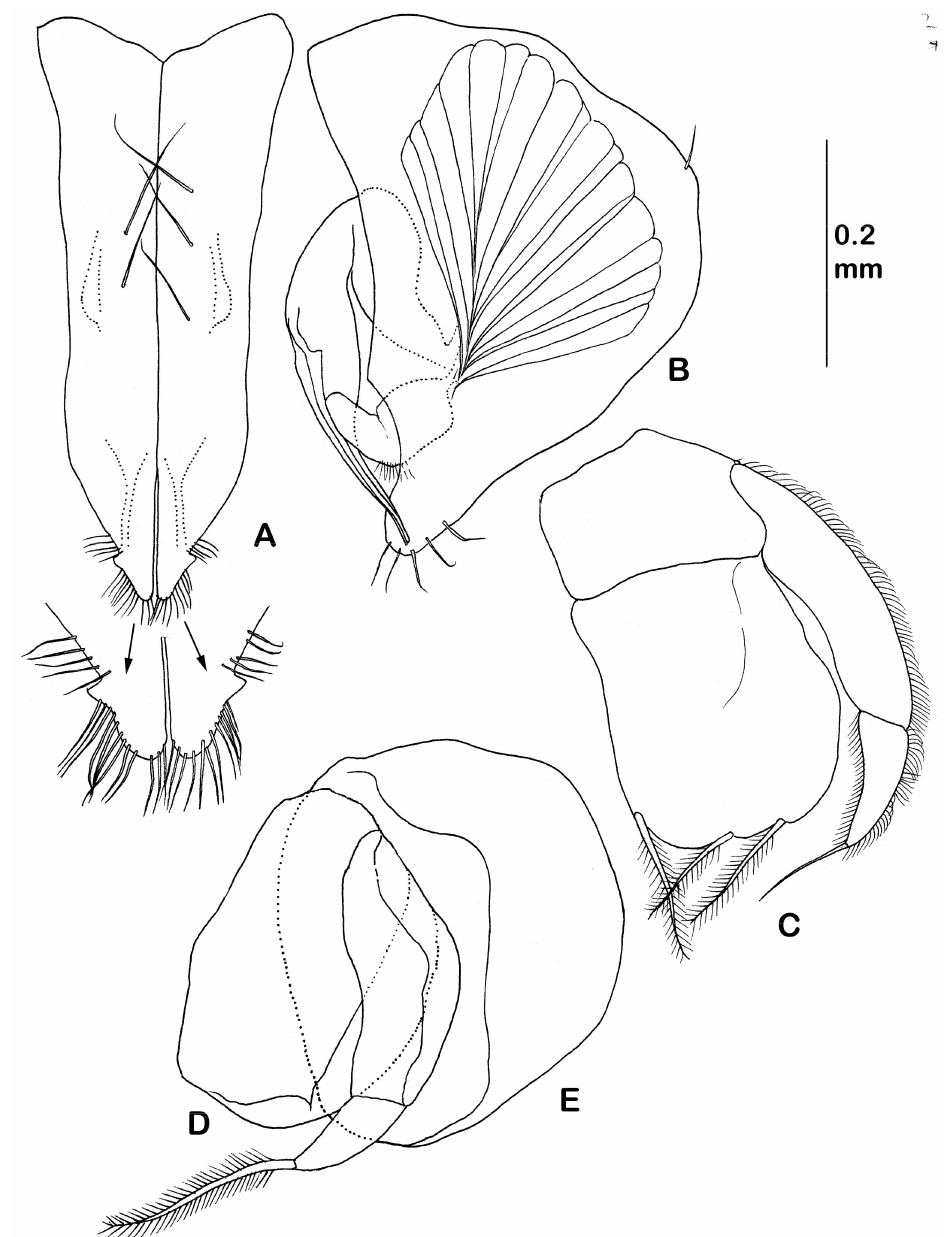
Figure 24. Eurycope gordeyi sp. nov. Male paratype (ZMH K-45645): ( A ) pleopod I (distal mar- gin enlarged); ( B ) pleopod II. Male paratype (ZMH K-45646): ( C ) pleopod III; ( D ) pleopod IV; ( E ) pleopod